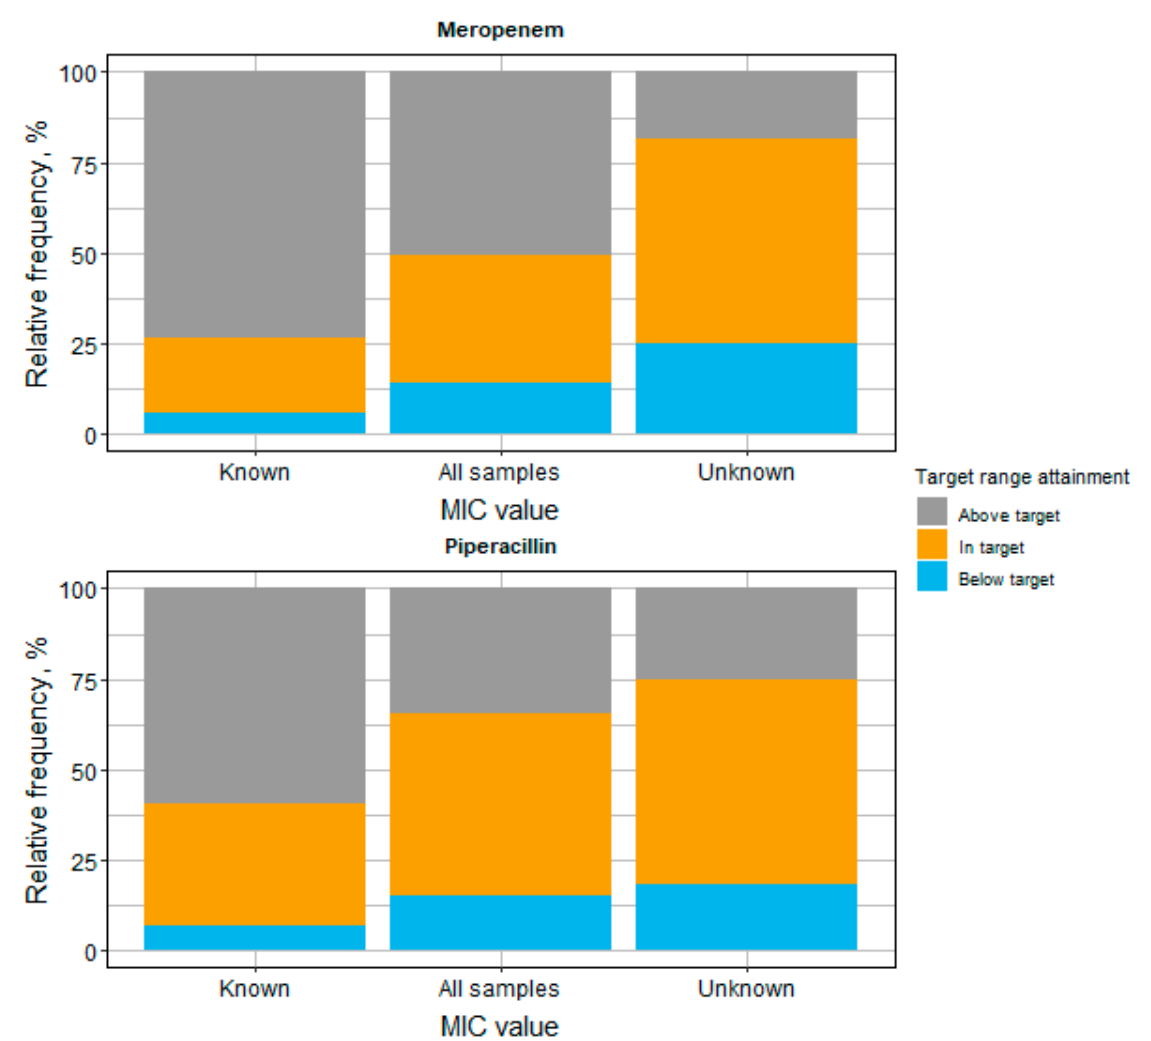
Figure 1. Target range attainment for meropenem and piperacillin stratified by the availability of susceptibility data (MIC value) for the pathogen causing the infection. Target range for the minimum drug concentration defined as 1–5 × MIC. If no MIC values could be determined, an empirical target of 8–40 mg/L and 16–80 mg/L was used for meropenem and piperacillin, respectively. Abbreviations: MIC: minimum inhibitory concentration .